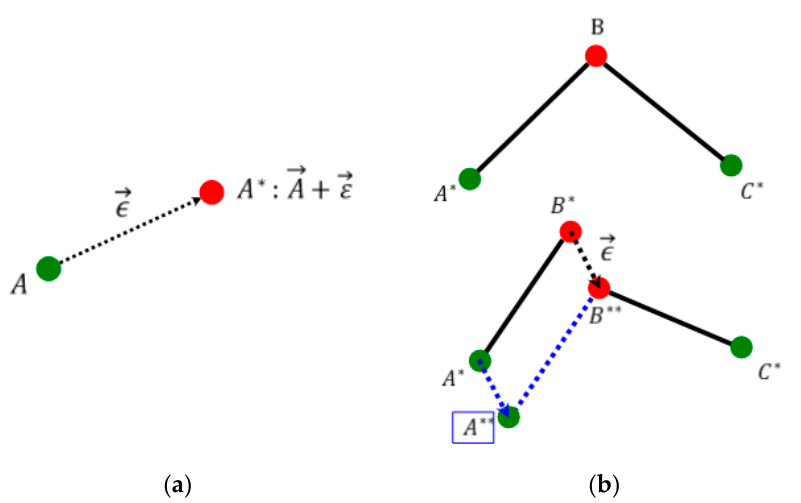
Figure 8. Applying joint clearances. ( a ) Fixed point (A). ( b ) Point (B) between fixed points.